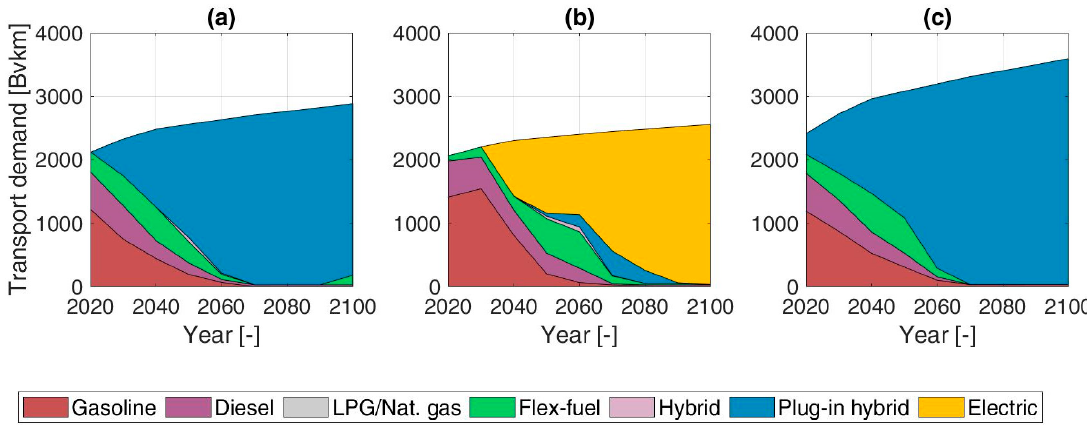
Figure 10. LDV fleet composition in the three analyzed storylines: A ( a ), B ( b ) and C ( c ).